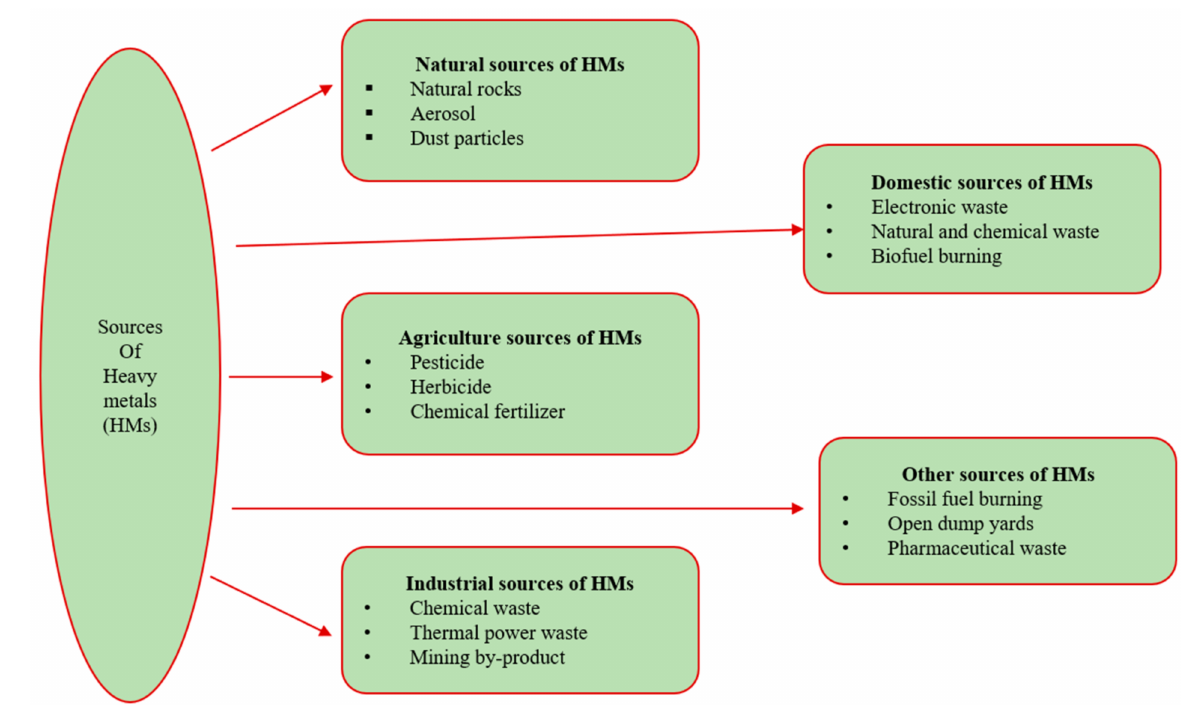
Figure 2. Various sources of heavy